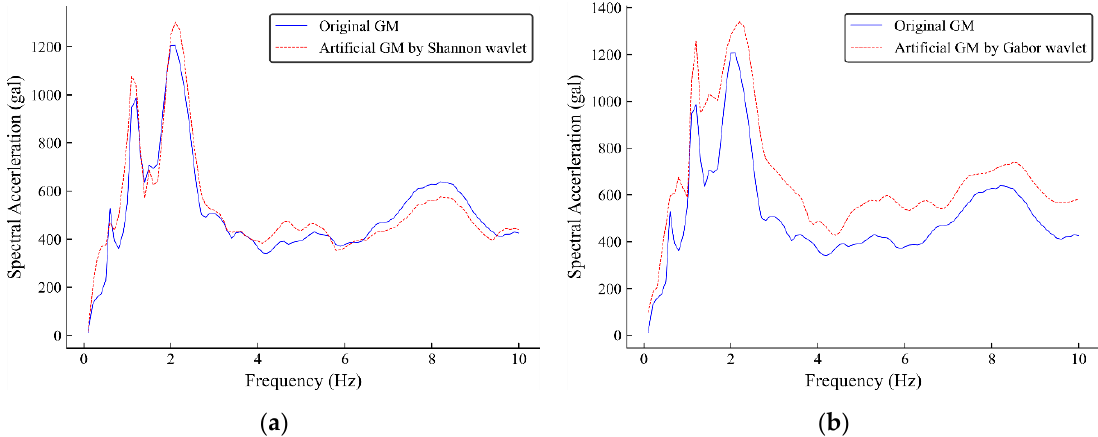
Figure 5. Comparison between response spectra of original ground motion and artificial ground motion generated by ( a ) Shannon wavelets and ( b ) Gabor wavelets.